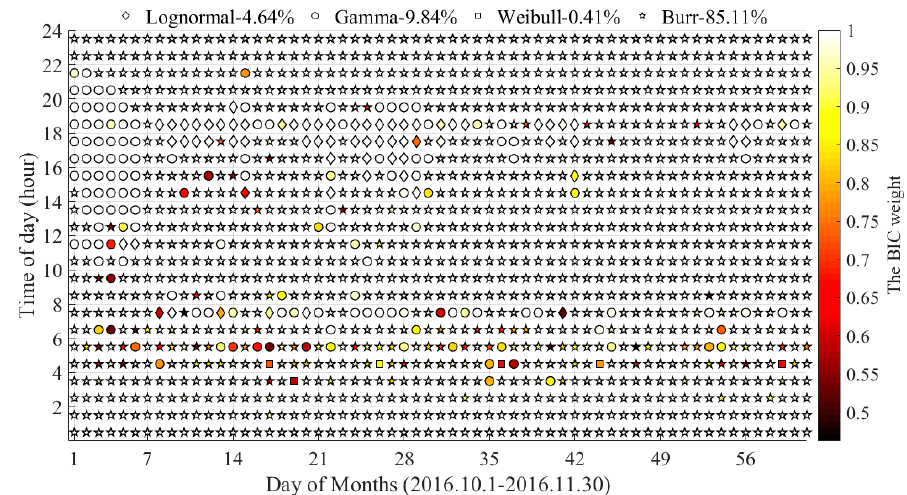
Figure 8. The fitting distributions of daily travel speed.